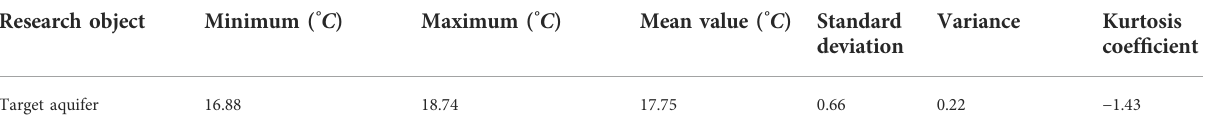
TABLE 6 The comprehensive table of the target aquifer simulation